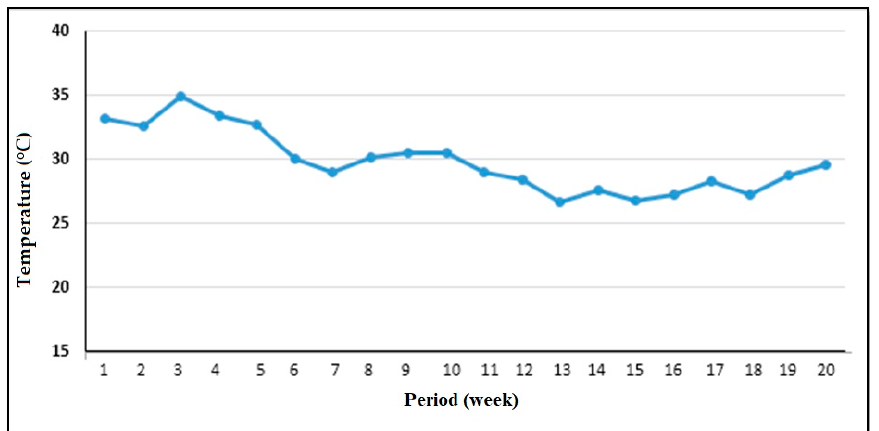
Figure 2. Average temperature (°C) under greenhouse conditions during the 2019 and 2020 experimental periods for zucchini growth.